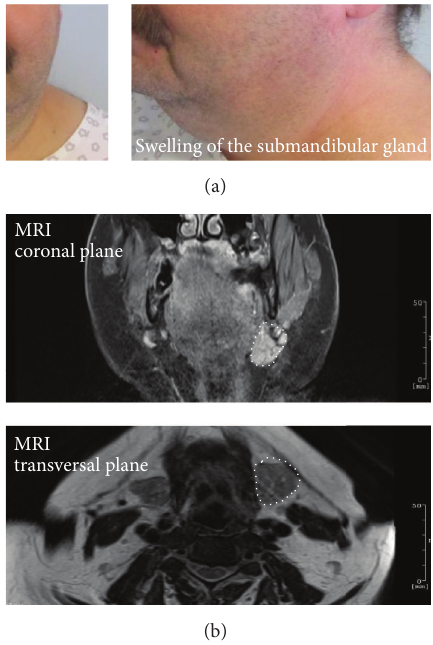
Figure 3: Acute mumps infection involving swelling of the left submandibular gland. (a) Photographs from the left submandibular region of the patient show a superior palpable tumor. (b) MRI reveals an enlarged left submandibular gland with contrast agent accumulation. The left submandibular gland is highlighted by a dotted white